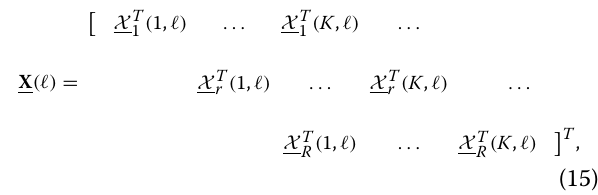
ˆ ( k , (cid:2)) , we use a variant of the H r